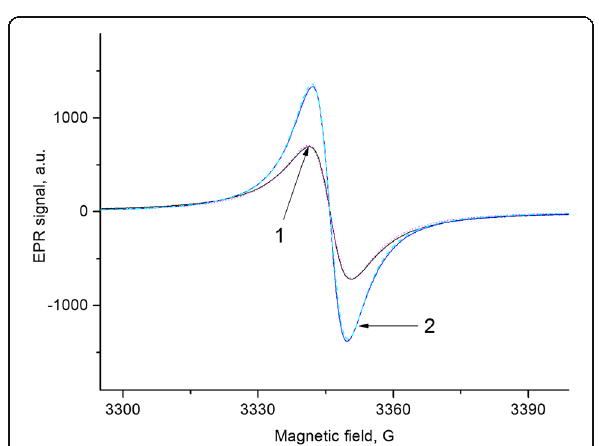
Fig. 6 The EPR spectrum of FS sample. 1 — The sample of FS was annealed 1 h at T = 550 ° C in the low vacuum, 2 — the sample of FS was stored 24 h in the ambient air after annealing